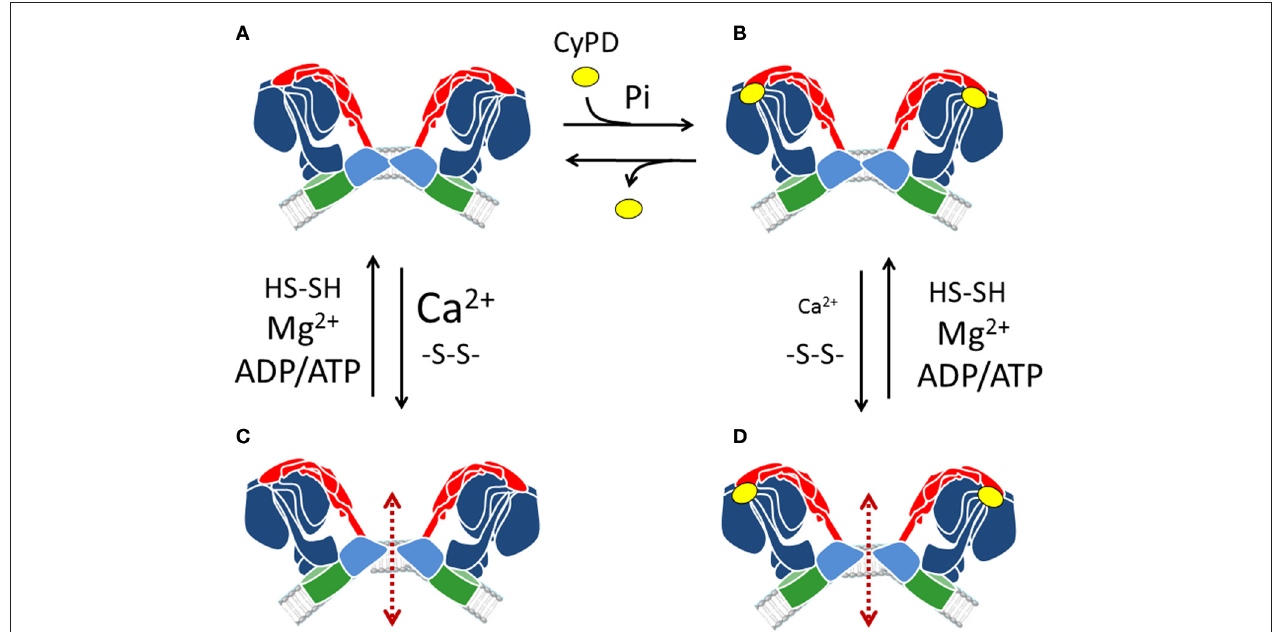
FIGURE 2 | Hypotheticaltransition of F O F 1 ATP synthase dimersto form the PTP. ATP synthase dimers (A) can undergoPTP formation whenCa 2 + ratherthanMg 2 + isbound,possiblyatthecatalyticsites,inareversibleprocess favoredbythioloxidation (C) . Bindingof CyPD, which is favoredbyPi (B) would